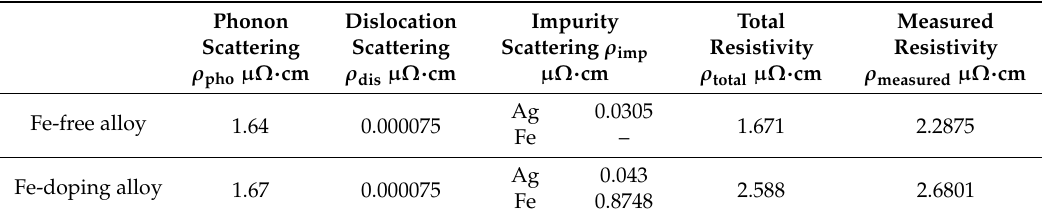
Table 4. Individual contributions to the resistivity of both Fe-free and Fe-doping alloys aged at 550 ◦ C for 4 h.